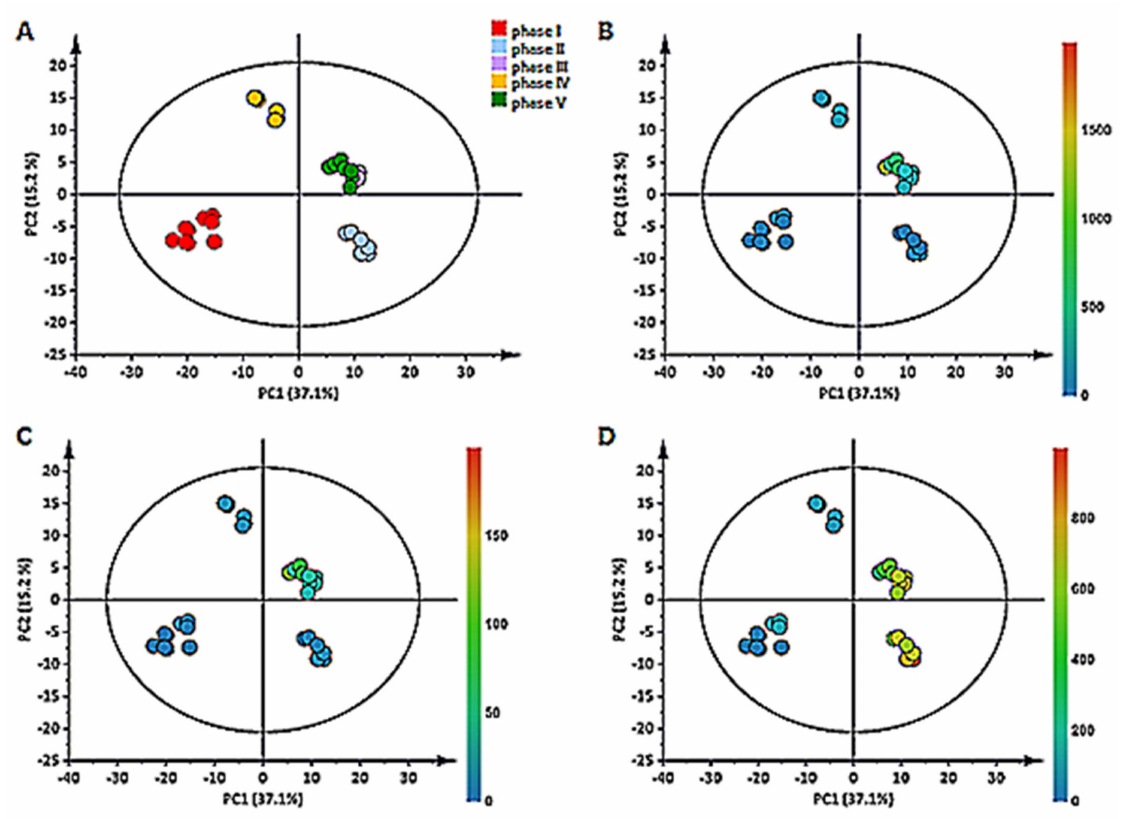
Figure 4. Principal component analysis (PCA) models of DMSO/methanolic extracts of H. roseoniger cells, analyzed by UHPLC–MS. The scores plot ( A ) was constructed from the first two principal com- ponents and shows clustering according to different harvest days post sclareol treatment (phases I–V) and clear separation of the metabolite profiles characteristic of the respective phases. The Pareto- scaled scores plot explains 52.7% and 43.5% of the total variation (PC1 and PC2). The quality parameters of the model were: explained variation/goodness of fit R 2 = 0.716, and predictive vari- ance Q 2 = 0.628. The ellipse indicates Hotelling’s T 2 distribution at a 95% confidence interval. The superimposed color-coded plots represent the distribution of selected ion peaks: ( B ) m / z = 273 (sclareol), ( C ) m / z = 251 (sclareolide) and ( D ) m / z = 237 (ambradiol). Differential time-dependent clustering of the samples of post-sclareol treatment